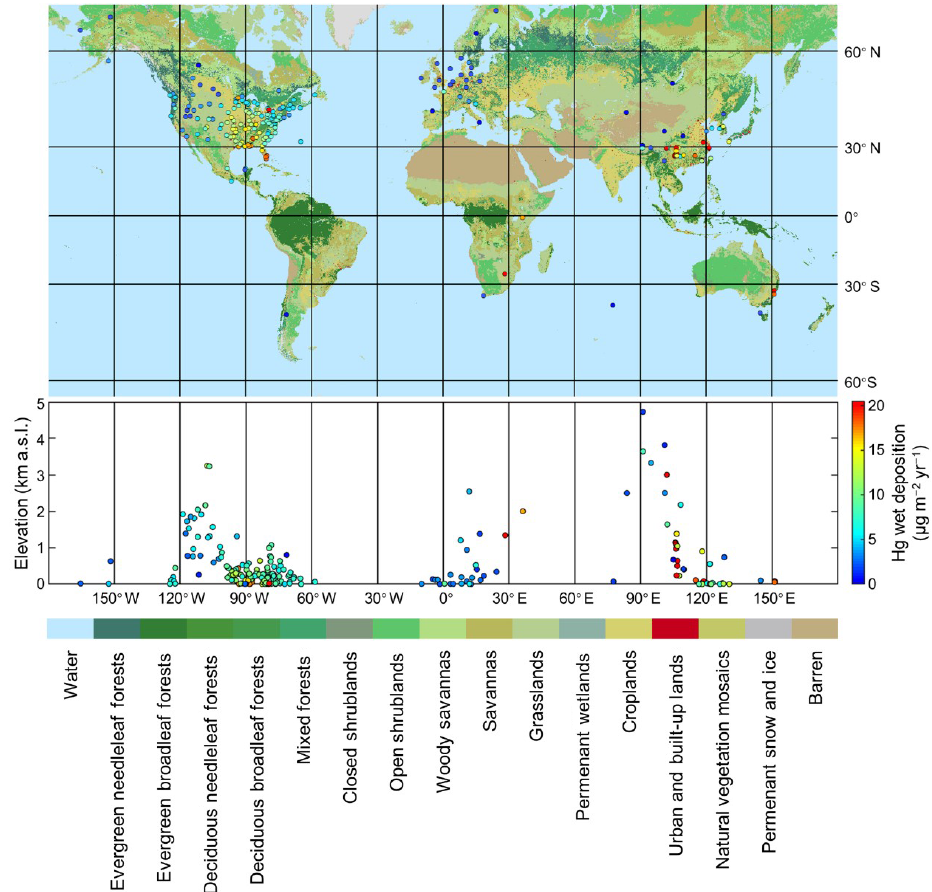
Figure 1. Global distribution of the observed Hg wet deposition fluxes by observation networks around the world (µgm − 2 yr − 1 ).